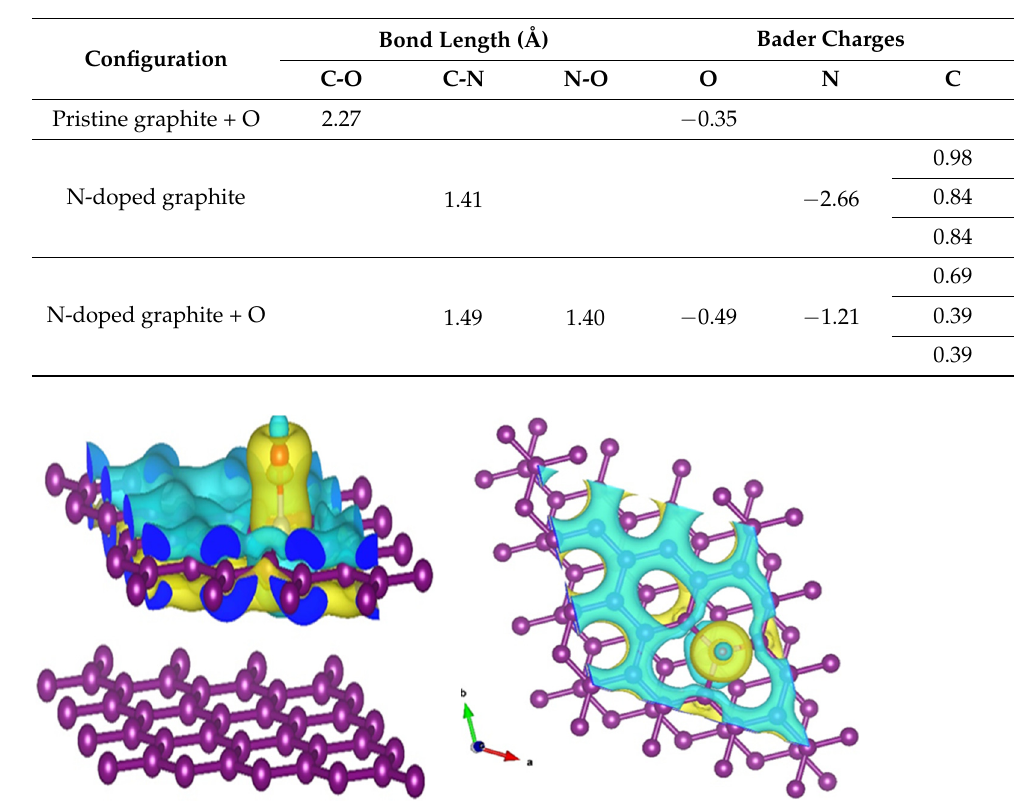
Table 3. Bond distances and Bader charges calculated for the pristine and N-doped graphite surfaces. Bader charges, calculated for the atoms nearest to the adsorbed O atom.